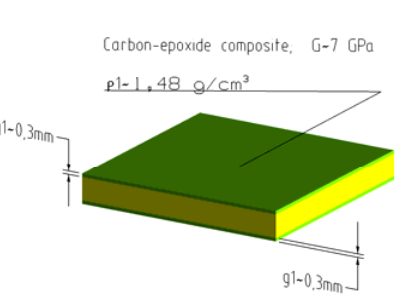
Fig 26. Sandwich skin used at outer wing design Spars flanges are designed so that the stress level is constant along the wing span. The initial design of the control surfaces assumes the application of two layers of carbon fabric with a specific weight of 163 g/m² and one layer with fabric that has a specific weight of 93 g/m². There will be three layers of fabric with a specific weight of 163 g/m² in the